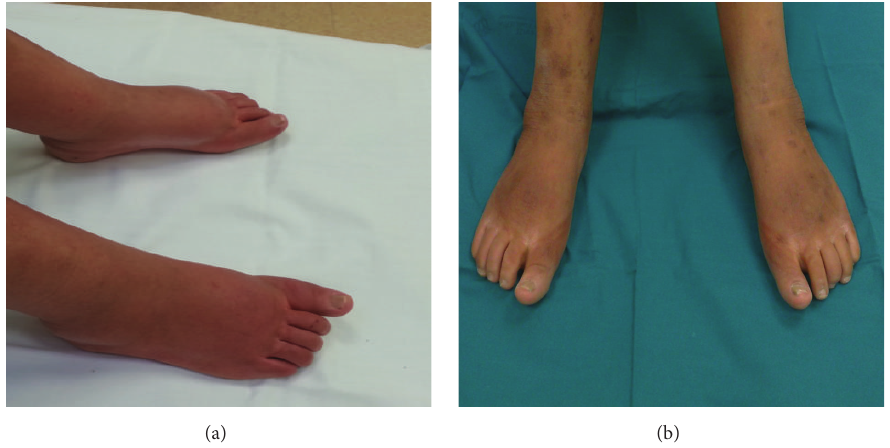
Figure 1: Patient legs and feet at the time of admission (a) and after one week of Ziconotide treatment (b).